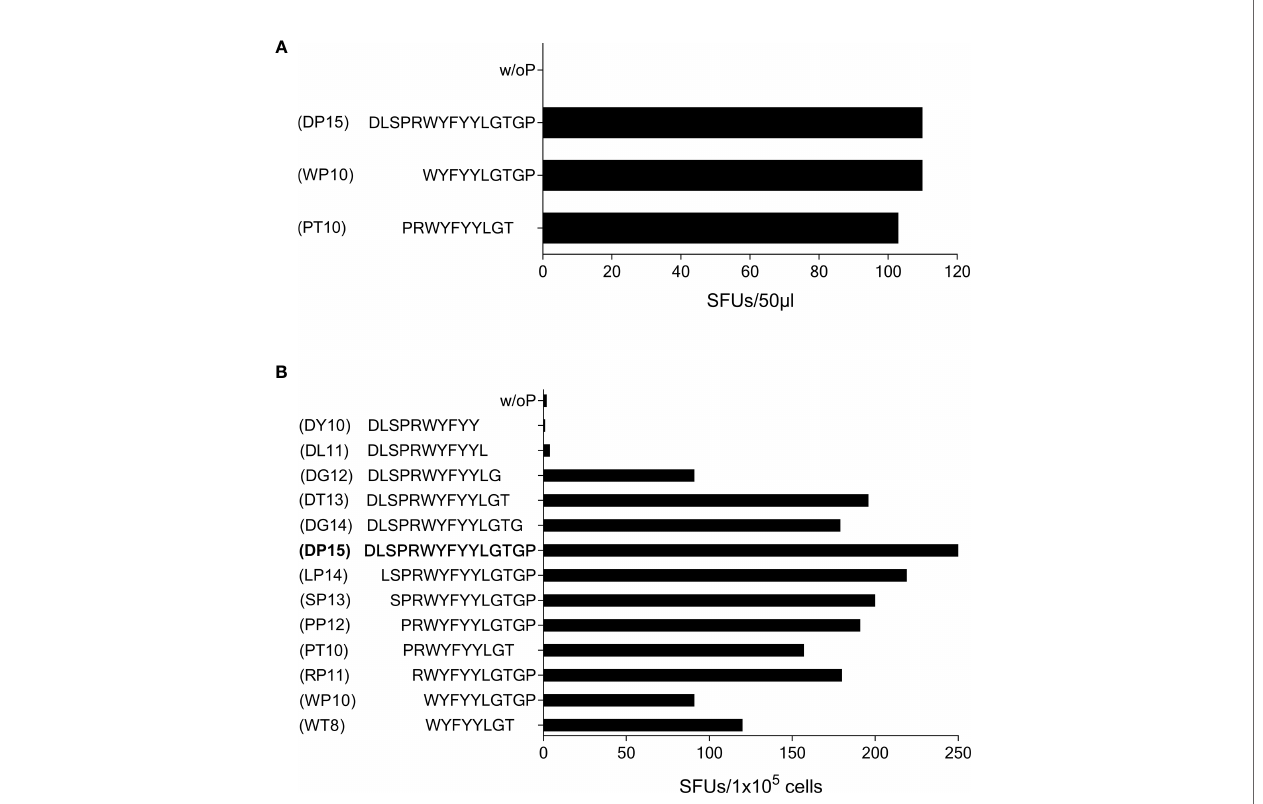
FIGURE 7 | T-cell recognition of peptides CoV-PT10 and CoV-WP10. (A) 50µl each of the SCoV-DP15-recognizing T-cell line from Donor 7 were stimulated in a g - IFN ELISpot assay with peptides SCoV-DP15, CoV-PT10 or CoV-WP10 at a fi nal concentration of 20µg/ml. Shown are SFUs per well after subtraction of background values in wells without addition of peptide. (B) 1x10 5 cells of the T-cell line from donor 6 were incubated in a g -IFN ELISpot assay with peptides D15, CoV-PP12, SCoV-DG12, CoV-RP11, SCoV-DL11, CoV-WP10, CoV-PT10, CoV-WT8 at a fi nal concentration of 20µg/ml. Responses are given as SFUs per 1x10 5 cells after subtraction of SFUs of wells without